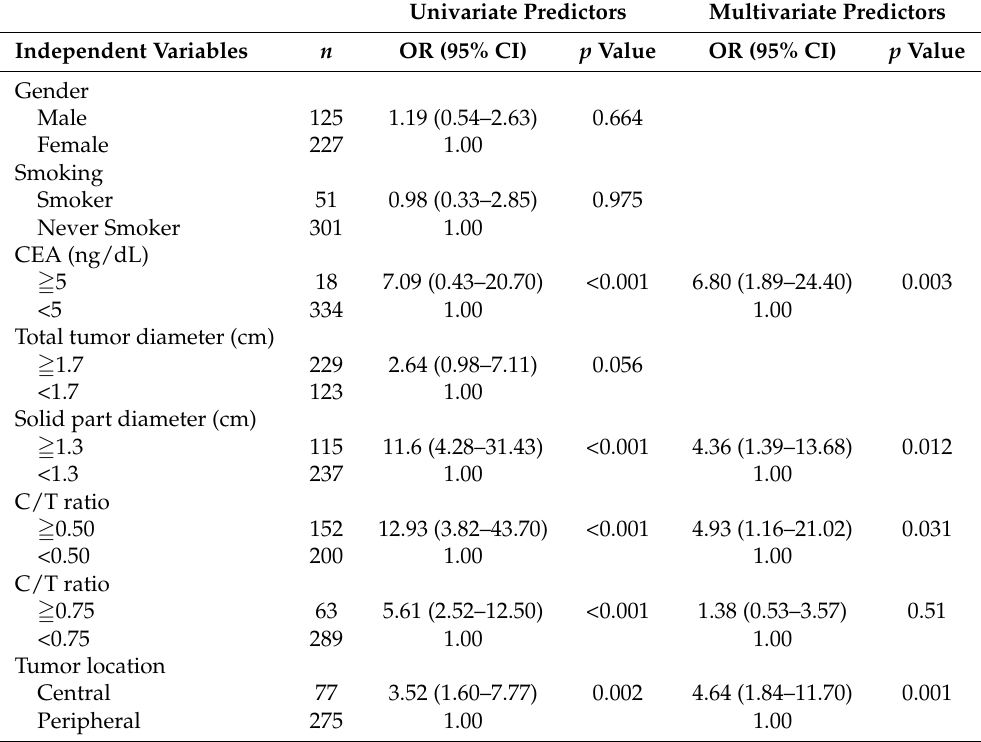
Table 3. The risk factors associated with lymph nodal upstaging according to logistic regression analysis. Univariate